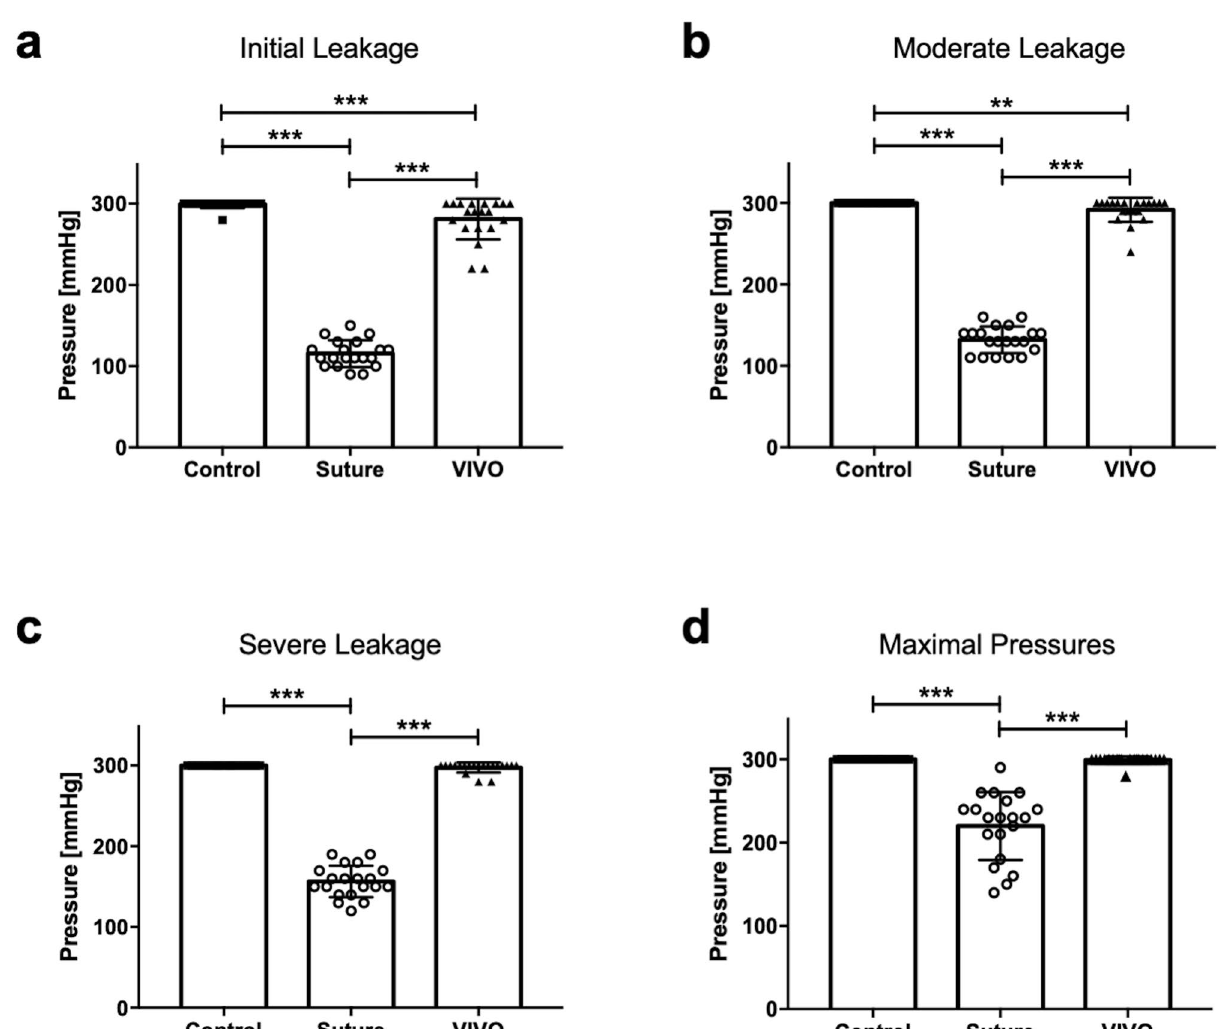
Figure 3. Scatter plot with bars of burst pressure test of all groups. The pressures at which initial leakage ( a ), moderate leakage ( b ), and severe leakage ( c ) were observed were significantly lower in the Suture group compared to the VIVO anastomoses. The maximum pressure values ( d ) were also significantly lower in the Suture group. The figures were created using GraphPad Prism 7.0. ***p ≤ 0.001; **p ≤ 0.003. All scatter plots represent the means ±